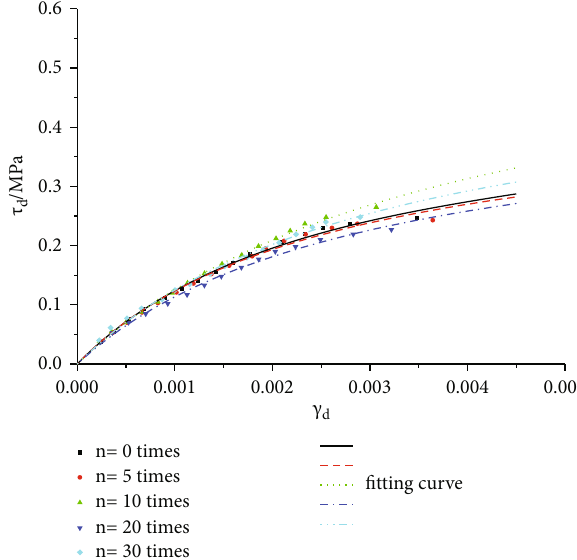
Figure 10: Relationship between di ff erent freeze-thaw cycles and secant